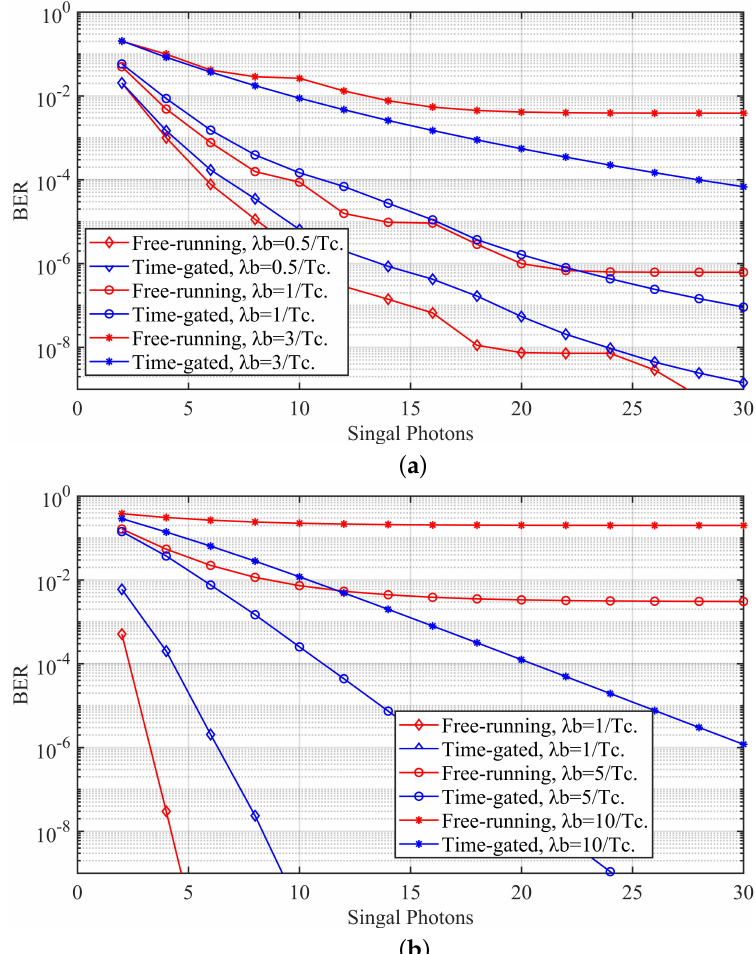
Figure 7. Performance comparison of time-gated SPAD and free-running SPAD. ( a ) N g = 16. ( b ) N g =